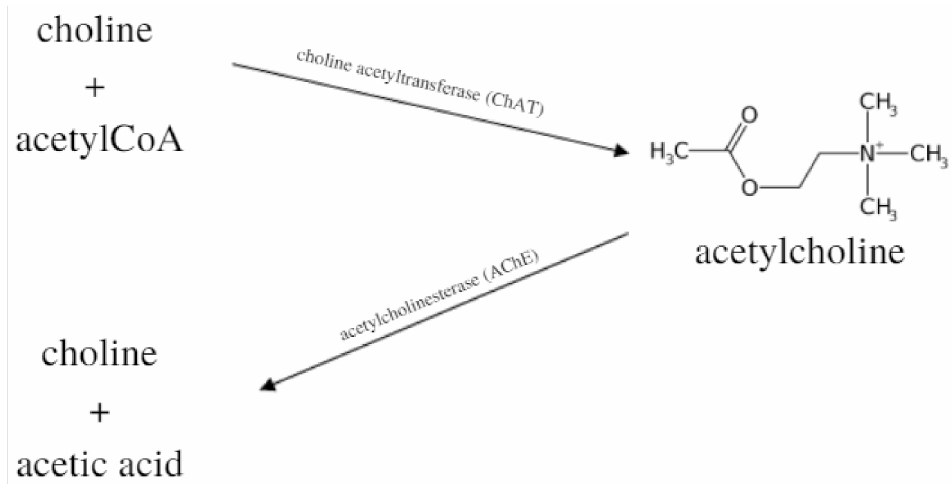
Figure 1. The synthesis and metabolism of the